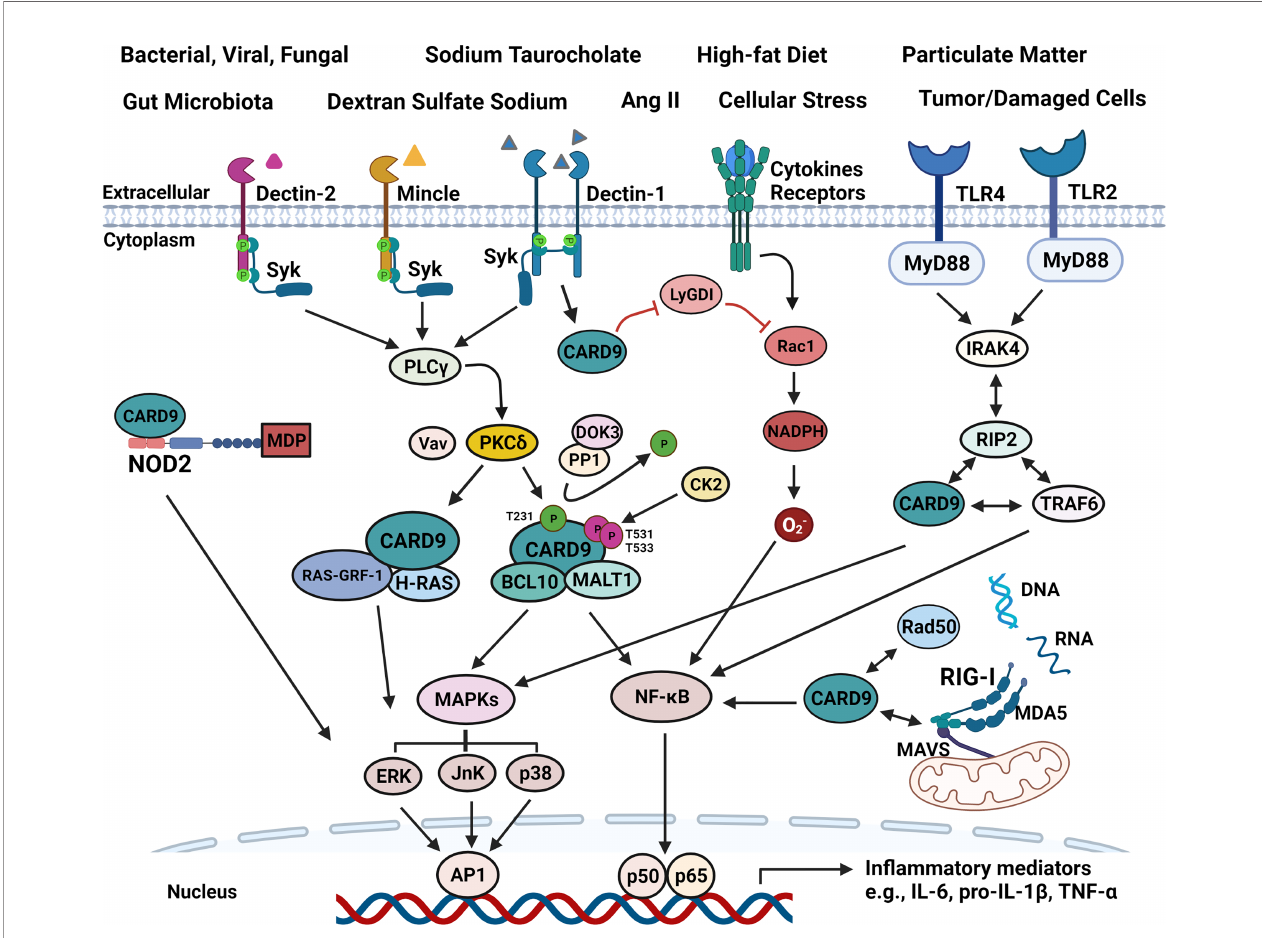
FIGURE 2 | Schematic illustration of signaling pathways associated with CARD9. All four main PRRs can interact with CARD9 to promote in fl ammatory mediator production upon stimulation from various risk factors, such as the components of bacterial, viral and fungal, high-fat diet, Ang II, particulate matter, tumor/damaged cells. (1). CARD9 transmits extracellular pro-in fl ammatory signals from SyK-CLRs (Dectin-1, Dectin-2, and Mincle), and MyD88-TLRs (TLR2 and TLR4). SyK activates PLC g , and then enhances the function of PKC d that is critically involved in CARD9 phosphorylation at T231 with the aid of Vav proteins in the coiled-coil domain, allowing the formation of CBM complex. DOK3-PP1 complex can dephosphorylate CARD9 to keep CARD9 in an inactive state. Meanwhile, CK2 can phosphorylate CARD9 at T531/ T533 to inhibit CARD9 function. The CBM complex activates NF- k B and MAPKs (ERK, JnK, p38), and subsequently increasing in fl ammatory cytokines production. CARD9 also binds with RAS-GRF-1 and H-RAS to activate ERK in response to Dectin-1-initiated SyK phosphorylation. RIP2 can bind with CARD9, IRAK4, and TRAF4 to activate NF- k B and MAPKs upon TLRs activation. (2). Intracellular signals, such as cytosolic MDP, DNA and RNA can be detected by NOD2, RAD50 or RIG-I-MDA5- MAVS to initiate p38, JnK or NF- k B signaling via CARD9, separately. In addition, CARD9 can free Rac1 from LyGDI to promote superoxide